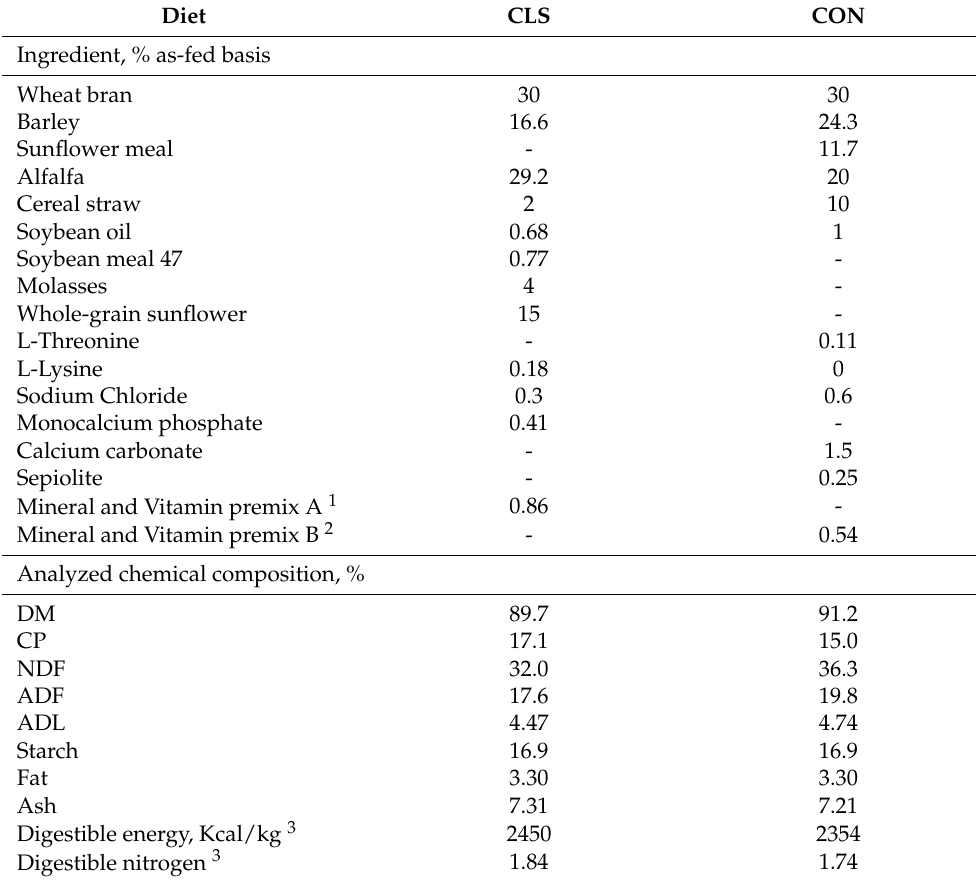
Table 1. Ingredients and chemical composition of lactating (Cunilactal Super (CLS)) and standard- growing (CON)